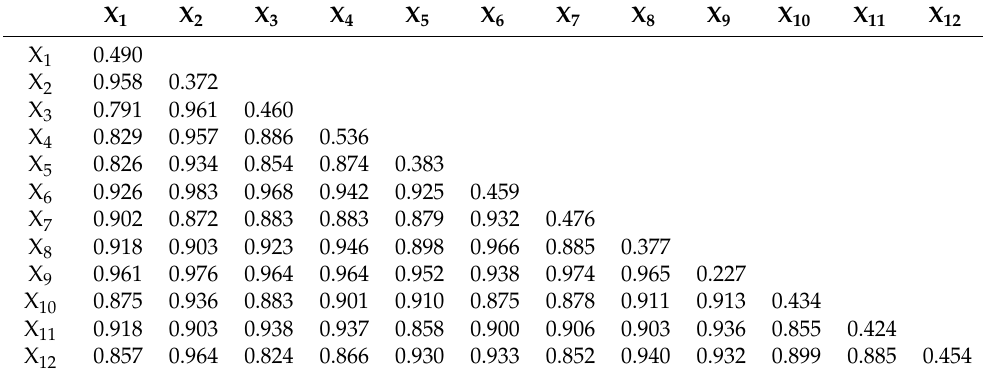
Table 3. Interaction analysis